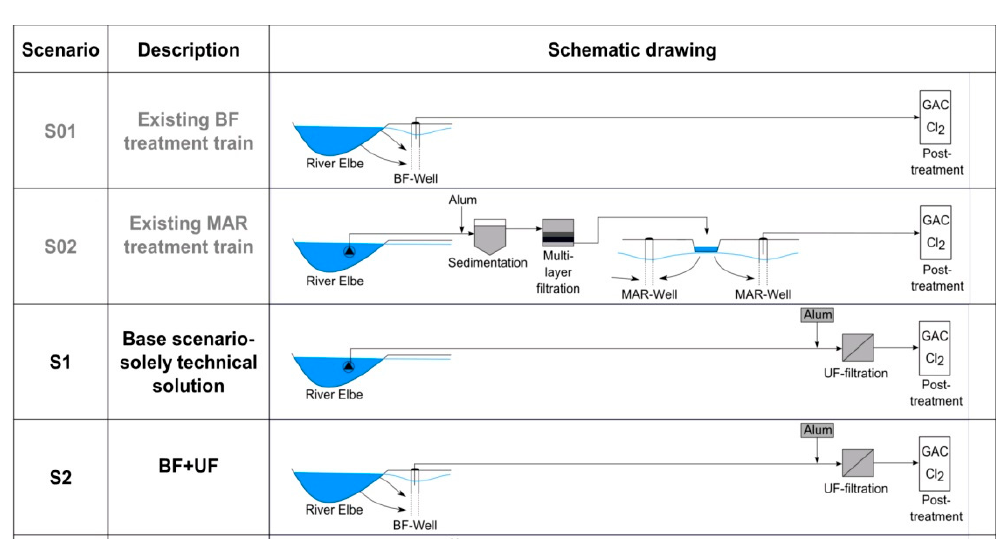
Figure 3. An overview of the treatment processes in the waterworks Dresden with Managed Aquifer Recharge (MAR) and the treatment scenarios S1 and S2 with an ultrafiltration plant (UF) and bank filtrate (BF) .